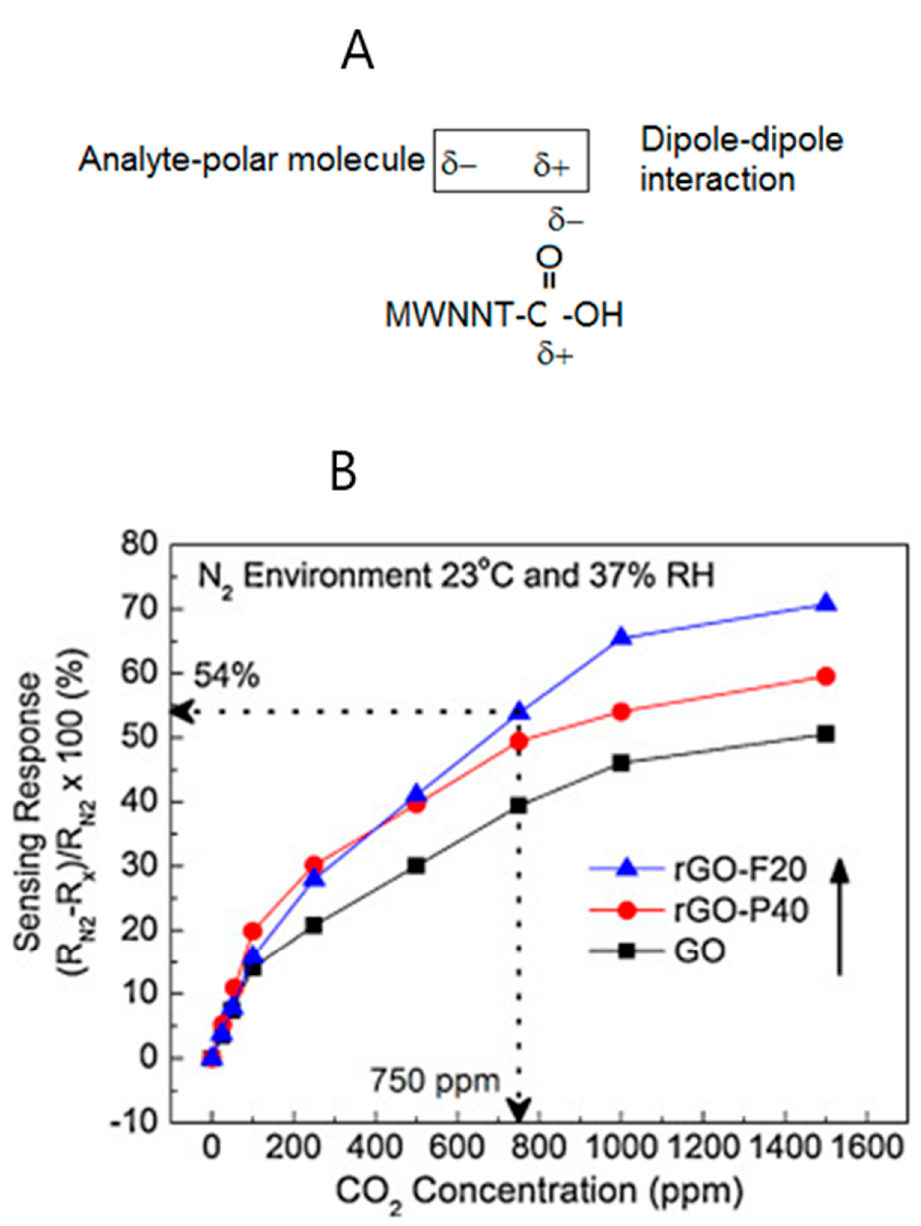
Figure 16. ( A ) Dipole-dipole interaction mechanism. ( B ) Graphene resistive sensor. Reproduced with permission from reference [49]. rGO: reduced graphene oxide; GO: graphene